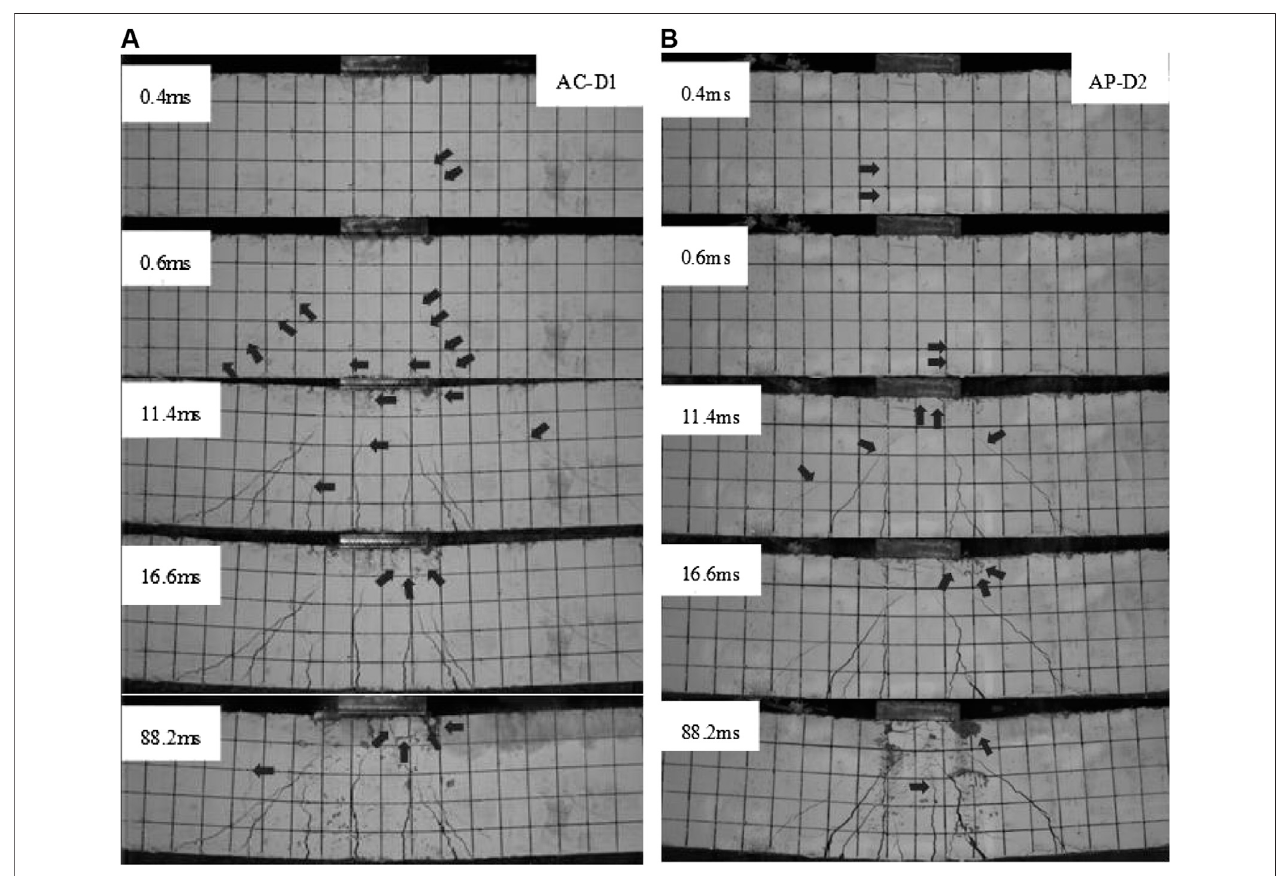
FIGURE 5 | Crack propagation. (A) AC-D1, (B)